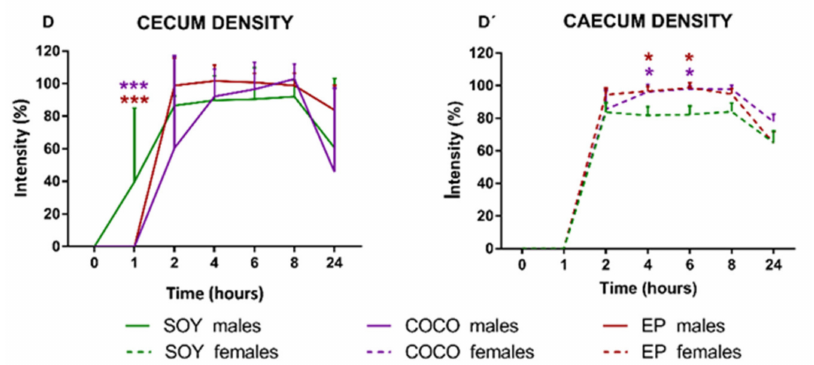
Figure 7. Effects of diet intervention on size and density of the stomach and cecum in the rat. Male ( A – D ) and female ( A’ – D’ ) rats were exposed to AIN-93G diet containing 7% of soybean oil (SOY), or to modified AIN-93G diet containing 3.5% of soybean oil supplemented with 3.5% of coconut oil (COCO) or with 3.5% of evening primrose oil (EP). Figures represent the size ( A , A’ ) and density ( B , B’ ) of stomach, and the size ( C , C’ ) and density ( D , D’ ) of cecum based on X-rays obtained 0, 1, 2, 4, 6, 8, and 24 h after contrast administration. Data were analyzed in males and females separately. Data are presented as mean ± S.D. ( n = 6–12 animals per group). Two-way ANOVA followed by Bonferroni’s multiple comparison. * p < 0.05, ** p < 0.01 and *** p < 0.001 vs. SOY males or females. Number, Size, and Density of Fecal Pellets A progressive increase in the number of fecal pellets from T4 until the end of the exper- iment was observed in males and females under SOY, COCO, and EP diets (Figure 8A,A’).